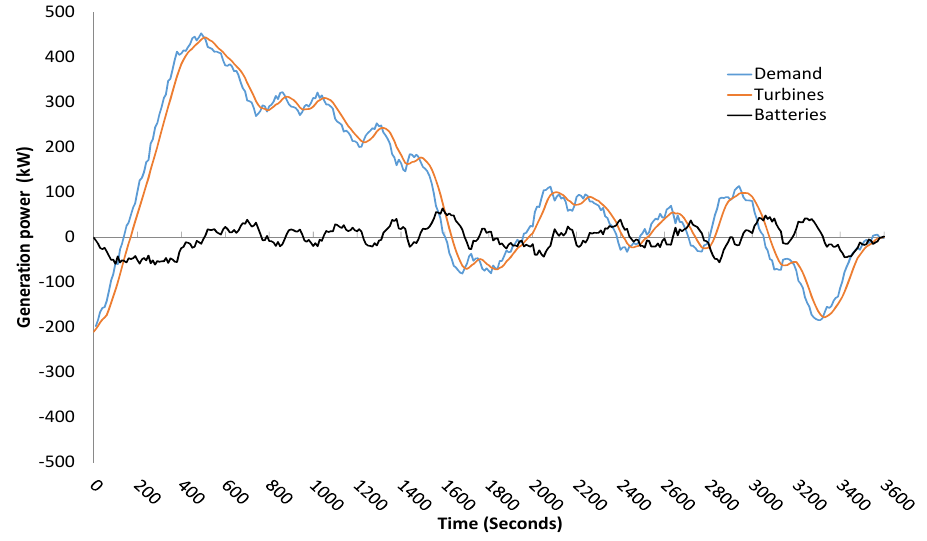
Figure 1. Working load of turbines and batteries in contrast to demand for the first scenario.